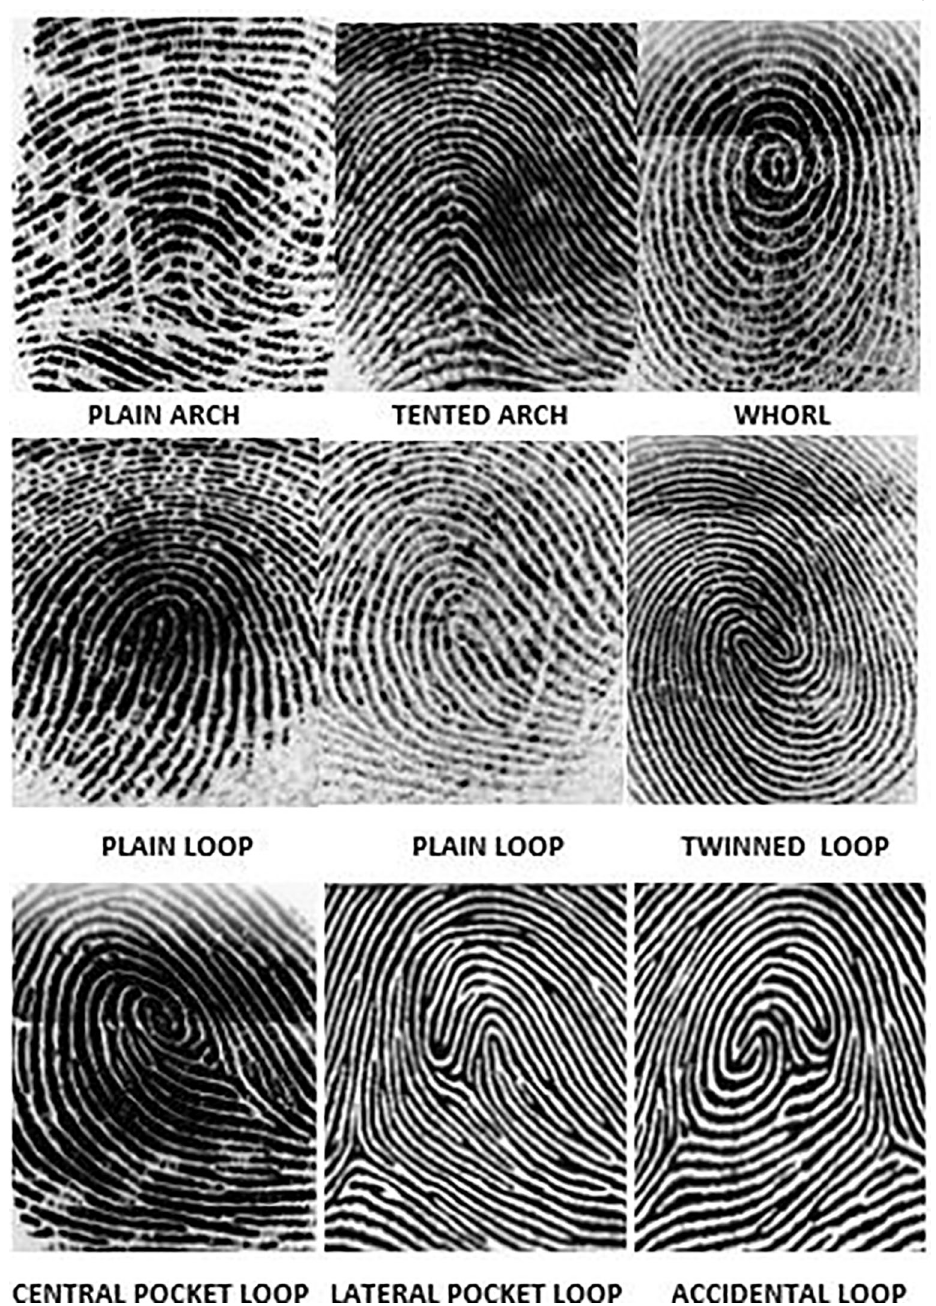
Figure 3. Henry ’ s classification of dermatoglyphic patterns.